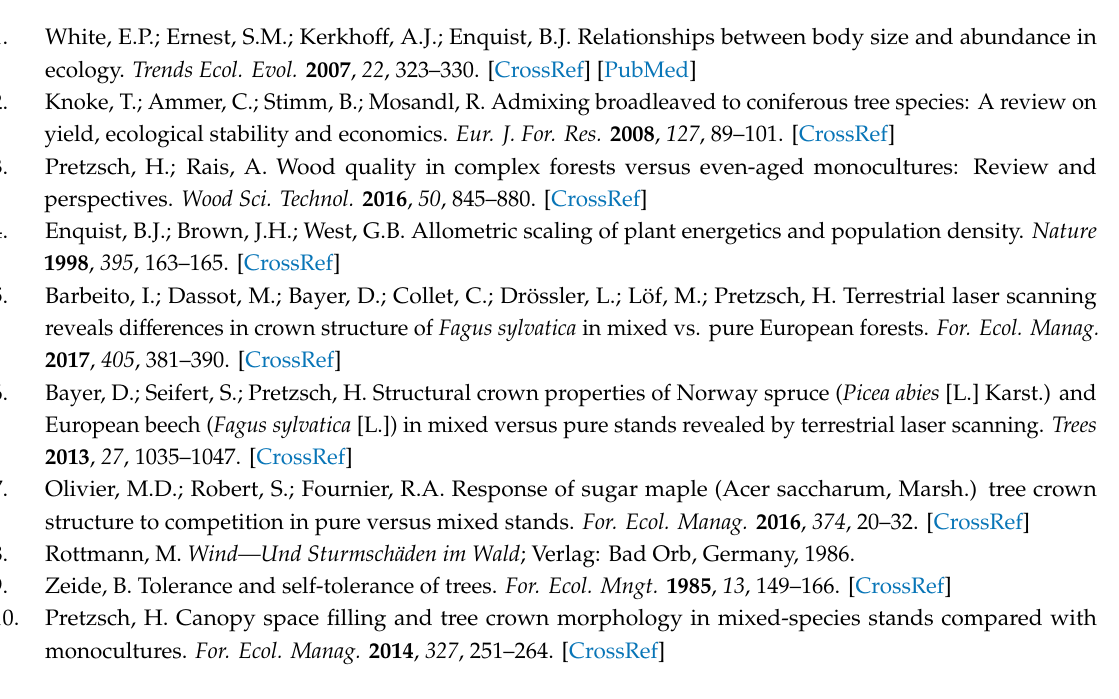
Table S1: Allometric factors a0 and allometric exponents a1 resulting from the 95% quantile regression models 5: Figure 10. Figure S1: Visualization of a concept for the changing cpa-d relationship of trees with progressing size development. In the young state the crown extension can vary in a broad allometric corridor and is mainly determined and restricted by the neighborhood and competitive situation of the tree. With progressing size development the variation of the crown extension decreases and is mainly restricted by the species-specific wood density. Thus, the crown dimensions of trees with di ff erent development histories approach the same species-specific limitation and may converge. The limitation of the branch length and crown expansion by the wood density contributes to understanding the characteristic convergence of the upper and lower cpa-d boundary lines (see e.g., Figures 4 and 9). Explanation S1: Detailed derivation of the standardized observed and expected N-dq values shown in Figure